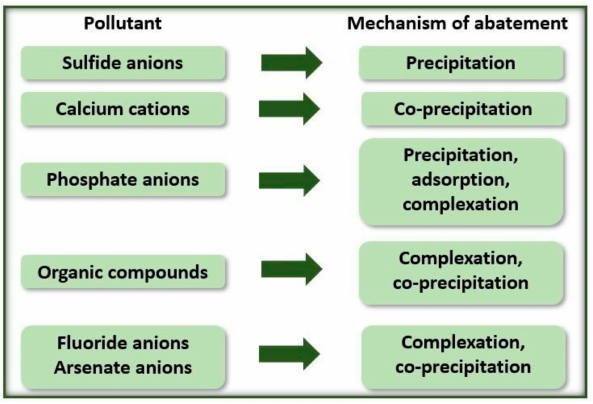
Figure 2. EC process removal mechanisms according to the type of